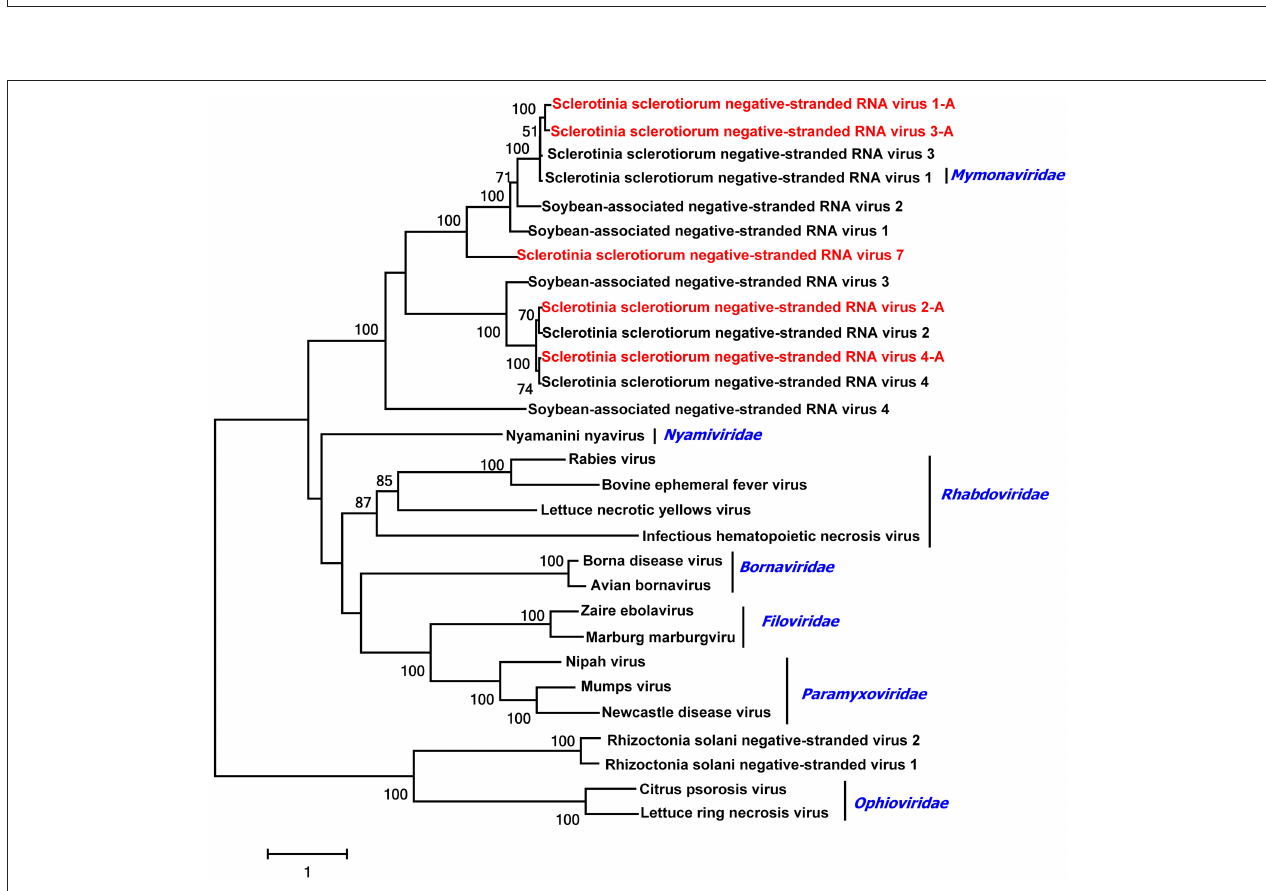
FIGURE 8 | Phylogenetic relationships of putative negative-stranded RNA virus genomes. For the neighbor joining tree, predicted RdRp amino acid sequences were aligned, and phylogenetic trees were constructed. Viruses marked with red color are found in Australian isolates of Sclerotinia sclerotiorum .